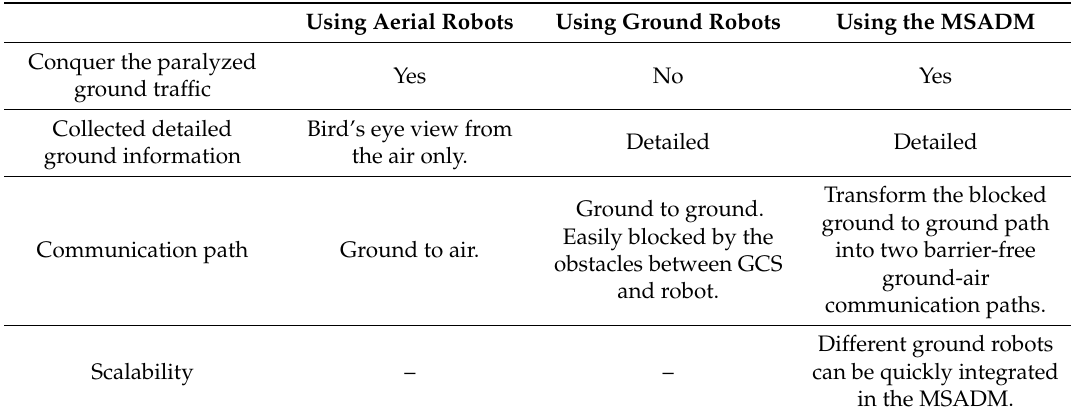
Table 2. Comparison with other sensing